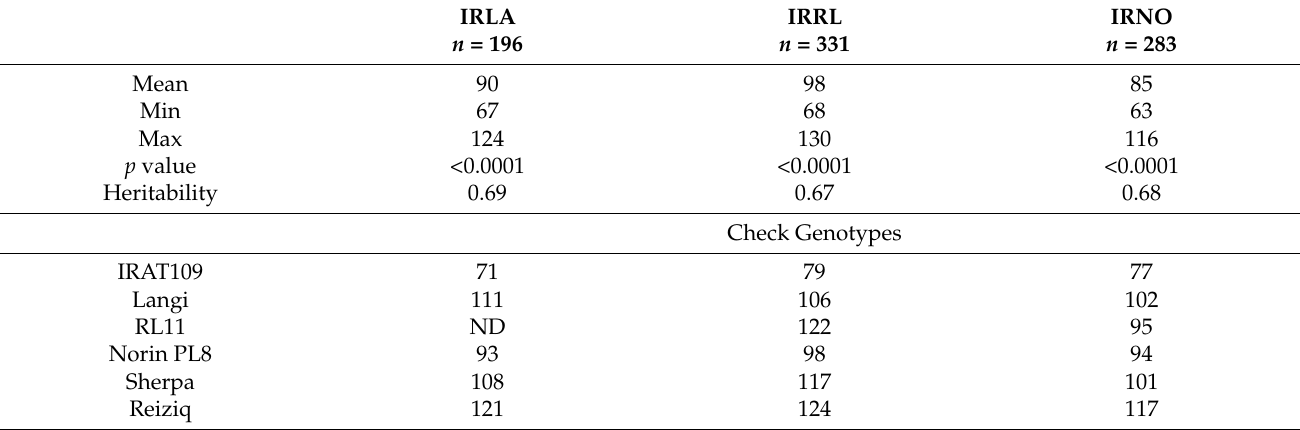
Table 1. RCA ( ◦ ) statistics of F 2 s derived from crossing IRAT109 with three recipient